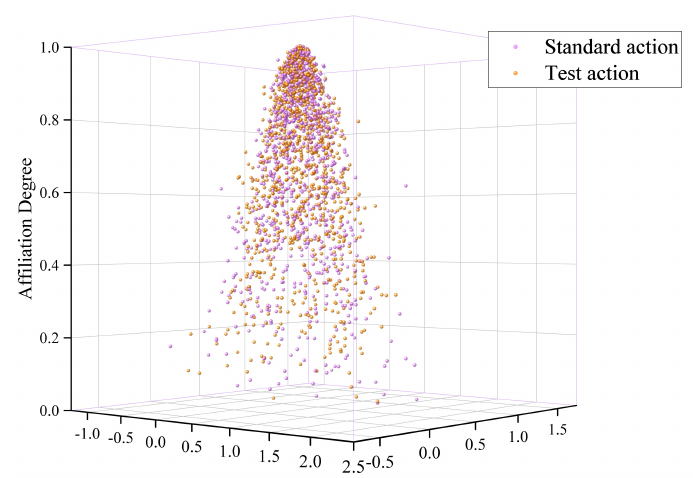
Figure 11. Cloud model containing action features of wearing a safety helmet.